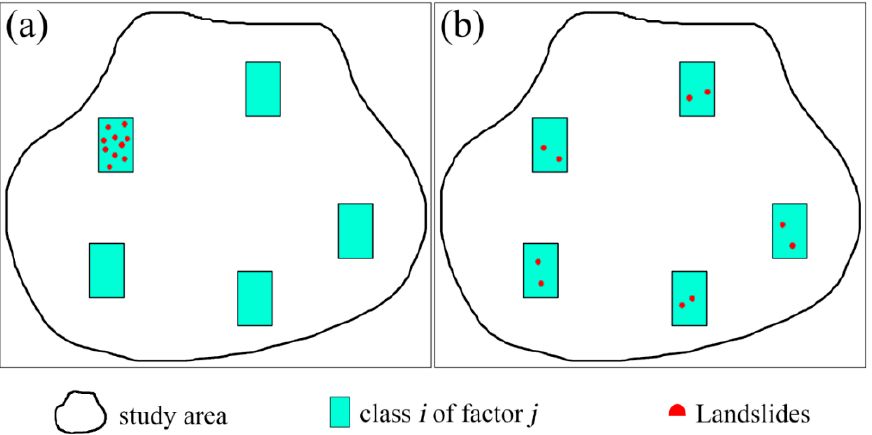
Figure 3. Degree of aggregation of landslides in two cases. ( a ) Case a; ( b ) Case